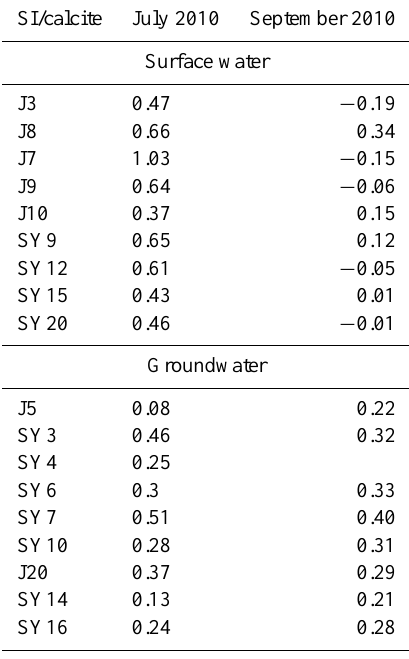
Table 5. Water saturation indices (SI) with respect to calcite in July and September. The PHREEQC was used to compute the saturation indices.